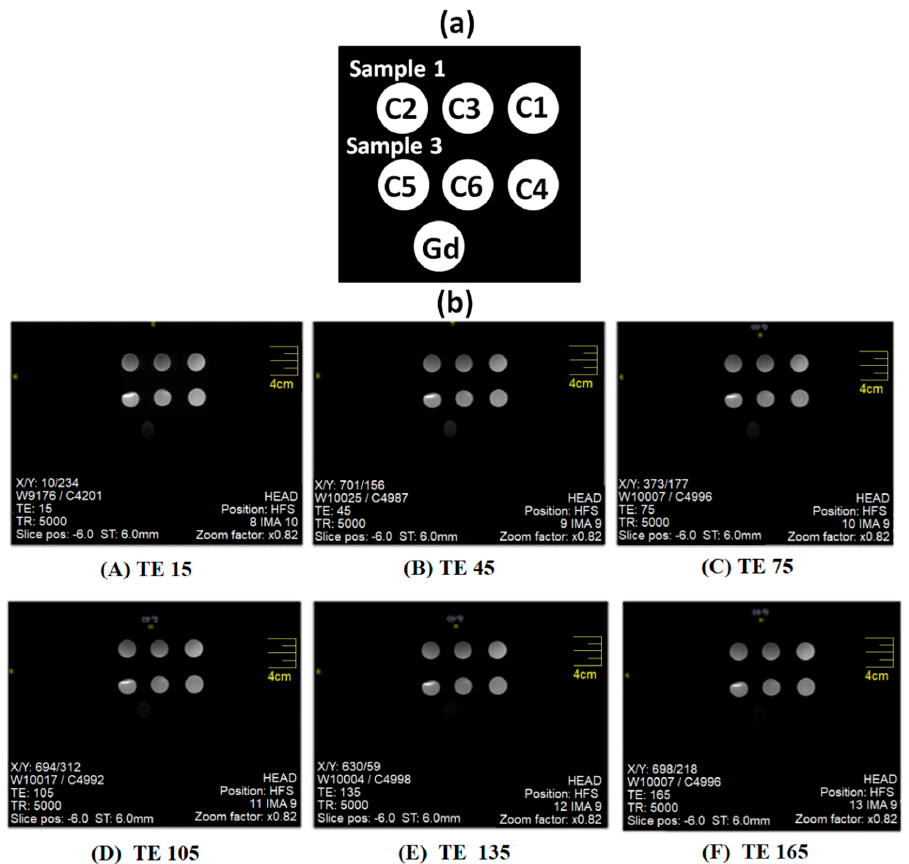
Figure 5. ( a ) Samples placement inside an MRI machine of the magnetic nanoparticles of samples 1 and 3 along with Gd as reference vials. See Table 2 for various samples concentrations samples 1 and 3 and Gd and ( b ) Acquisition of T2 images for magnetic nanoparticles of samples 1 and 3 along with Gd as reference vials at TR 5000 and various TE